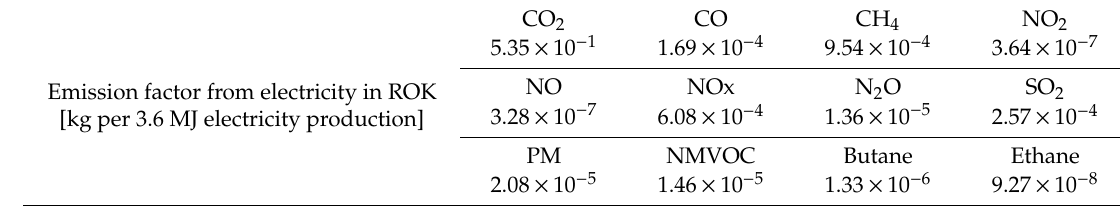
Table A8. Emission factors of electricity in ROK at the Well-to-Tank phase.